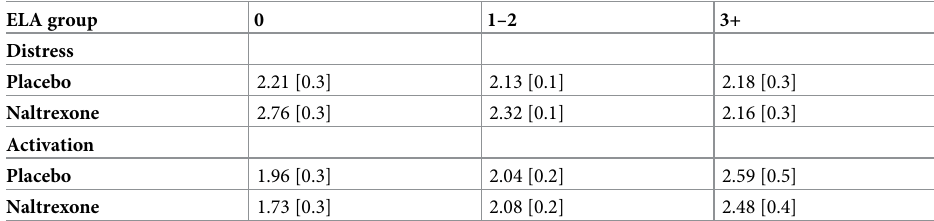
Table 2. Reports of activation and distress following